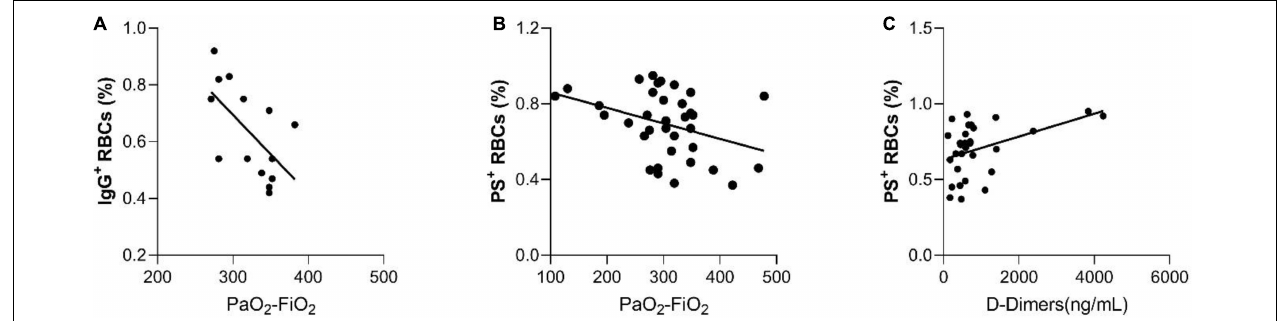
FIGURE 3 | The significant correlations between hemolysis and RBC markers with disease severity, as it is defined by PaO2/FiO2 ratio. (A) Correlation of IgG + RBCs with the PO 2 /FiO 2 ratio, (B) Correlation of PS + RBCs with the PO 2 /FiO 2 ratio, and (C) Correlation between D-Dimers and PS +